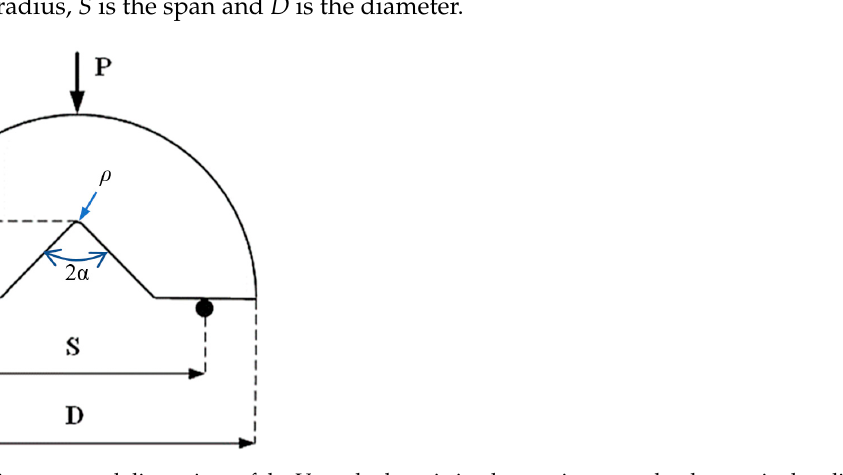
Figure 1. Geometry and dimensions of the V-notched semi-circular specimens under three-point bending.